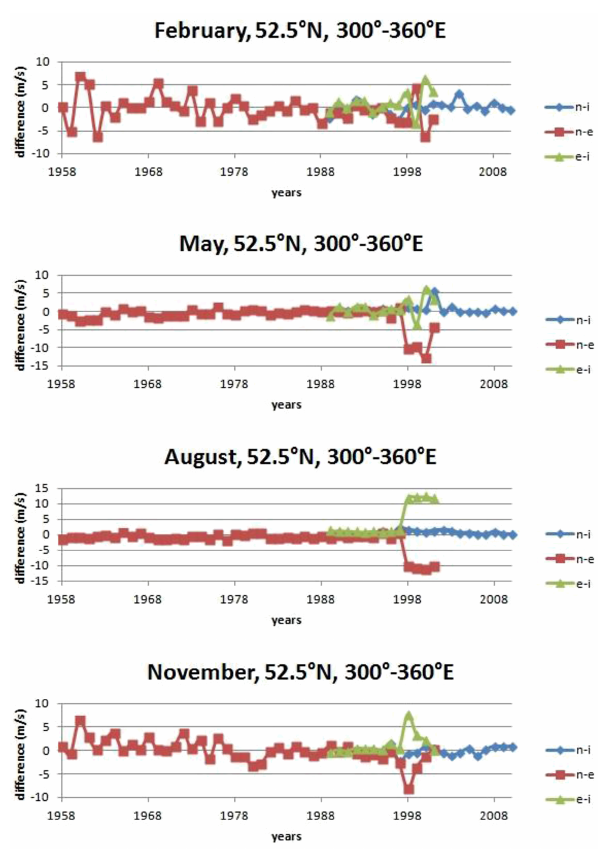
Fig. 4. Differences between reanalysis for February, May, August and November averages, 52.5 ◦ N, sector 300–360 ◦ W for 10hPa; e – ERA-40, n – NCEP/NCAR, I – ERA-Interim. Where differences overlap, only one colour is displayed.